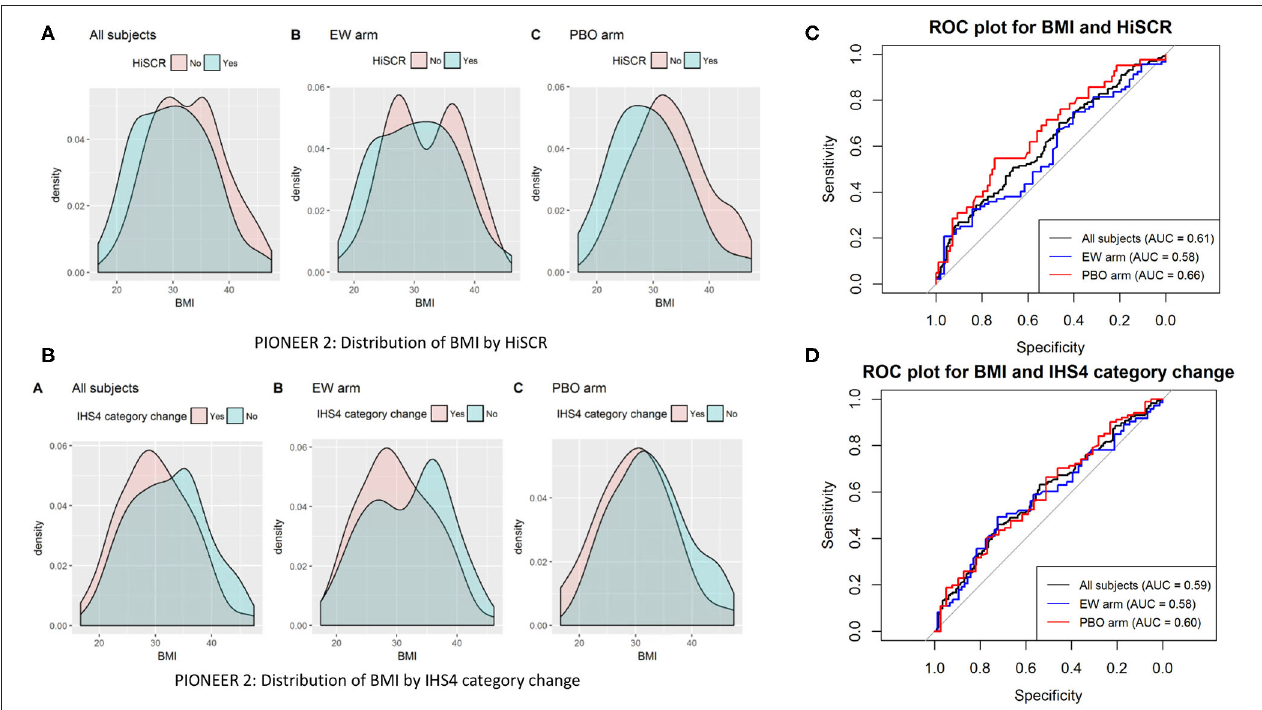
FIGURE 1 | Distribution (A,B) and ROC plots (C,D) . Receiver operating characteristic (ROC) curves of BMI against HiSCR and IHS4 category